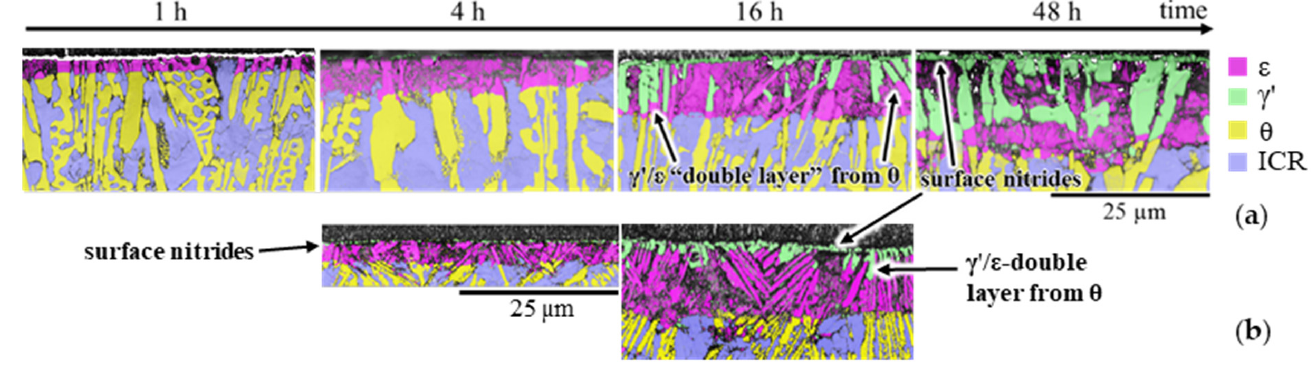
Figure 4. Cross-sectional EBSD phase maps of the compound layers of white-solidified ( a ) M-3.5C-3Si model alloy [8] and ( b ) remelted commercially available T-2.5Si-0.2Mn-0.1Cu ferritic cast iron [8,31], nitrided at 540 °C for the indicated periods of time and at K N = 1 atm − 1/2 .